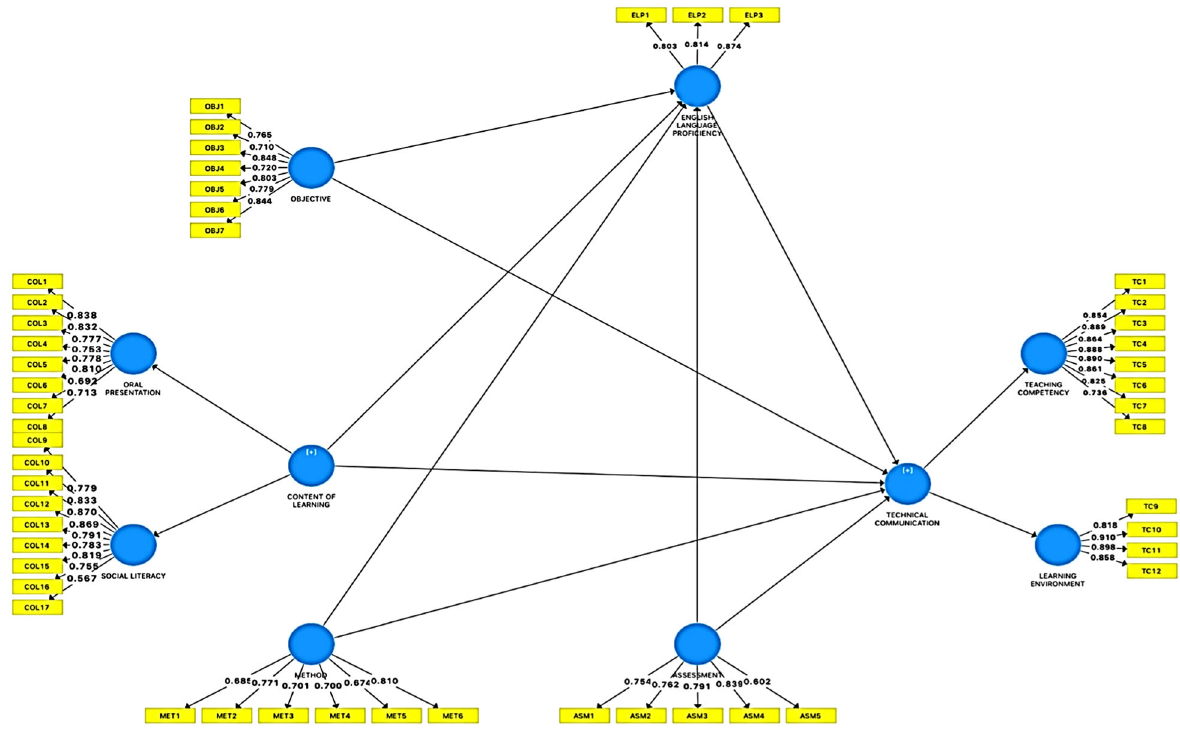
Fig. 2 The initial measurement model. The constructs and indicators for each construct with their loading